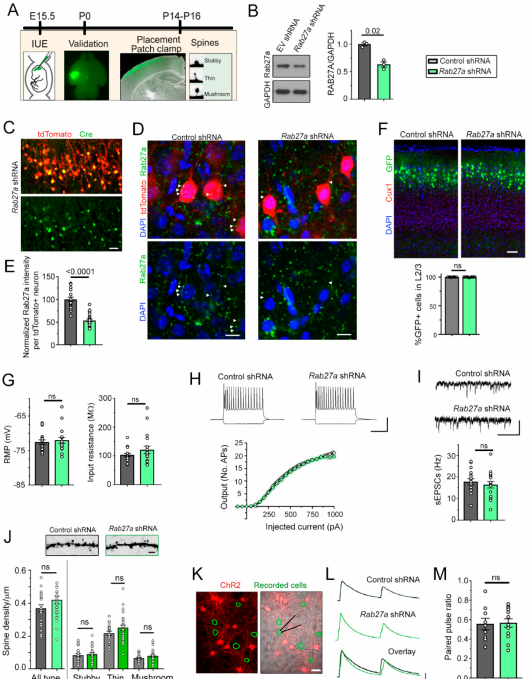
Figure 1. Rab27a knockdown does not affect cortical neuron placement and excitatory synaptic integration in a cellautonomous manner. ( A ) Diagram of the experimental paradigm. IUE: in utero electroporation. ( B ) Immunoblots of Rab27a, GAPDH from neurons containing empty vector (EV, control) or Rab27a shRNA and quantification of the blots shown in ( A ). ttest, N = 3 sets of cultures. ( C ) Images of tdTomato fluorescence and Cre immunostaining in coronal section from a (postnatal day) P14 mouse electroporated at embryonic day ( E ) 15 with Dcx -Cre, tdTomato, and Rab27 shRNA. ( D , E ) Z-stack images of tdTomato fluorescence, DAPI, and Rab27a immunostaining in coronal sections from P14 mice electroporated with either control or Rab27a shRNA ( D ). Plots of the normalized Rab27a intensity per cell in both conditions ( E ). ( F ) Top: images of Cux1 immunostaining and GFP + neurons containing control or Rab27a shRNA in coronal sections from P14 mice. Blue: DAPI overlay. Bottom: graph of the % of GFP + neurons expressing Cux1 and in layer (L) 2/3, the placement of neurons electroporated at E15.5. ( G ) Bar graphs of the mean resting membrane potentials (RMP) and input resistance of neurons expressing control or Rab27a shRNA. ( H ) Representative current-induced firing of recorded neurons and resulting input–output curves in both conditions. ( I ) Representative recordings of sEPSCs in neurons containing control or Rab27a shRNA and bar graphs of sEPSC frequency in both conditions. ( J ) Images of spines in each condition, and density of spines (all types) and of each individual type of spines in GFP + neurons containing control (n = 21) or Rab27a (n = 26) shRNA. ( K ) Images of tdTomato + neurons co-expressing ChR2 with control or Rab27a shRNA. The green circles delineate recorded neurons. Cortical neurons were nucleofected with Rab27a or control shRNA, and a plasmid encoding channelrhodopsin (ChR2) fused to mCherry. After plating, non-mCherry neurons were recorded at DIV 14 while light stimulation triggered spiking of ChR2- exressing neurons, resulting in synaptic release. ( L ) Representative examples of paired pulse traces induced by light stimulation of ChR2 in tdTomato + neurons expressing control or Rab27a shRNA that are neighboring recorded neurons. ( M ) Plots of the mean paired pulse ratio. n = 9 neurons in control condition and n = 13 neurons in the Rab27a shRNA condition. Unpaired t-test and one-way ANOVA, ns: not significant and ** p < 0.01, *** p < 0.001, **** p < 0.0001. Scale bars: 200 µ m ( C ), 30 µ m ( D ), 100 µ m ( F ), 50 mV, 200 ms ( H ), 20 pA, 200 ms ( I ), 2.5 µ m ( J ), 25 µ m ( K ), and 50 pA, 100 ms ( L ). Plots are mean ± SEM including data